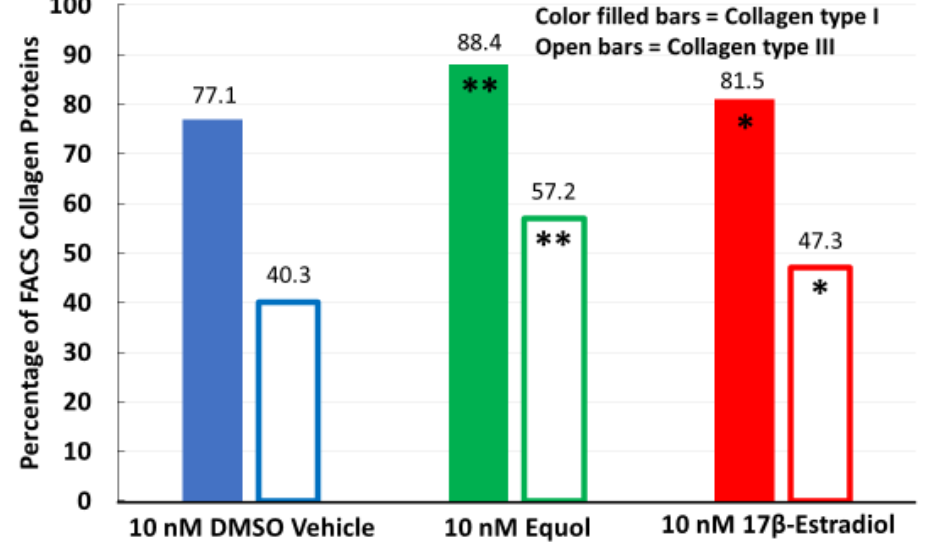
Figure 3. Intracellular Fluorescent-activated Cell Sorting (FACS) analysis in long-term (eight-week) tissue cultures quantifying collagen types I and Type III levels as the percentage of cells expressing each collagen type by treatment (after four days of exposure). Each bar represents 20,000 cells examined per data file. ** = Significantly greater compared to DMSO or 17 β -Estradiol levels ( p < 0.001). * = Significantly greater compared to DMSO vehicle control values ( p < 0.001).